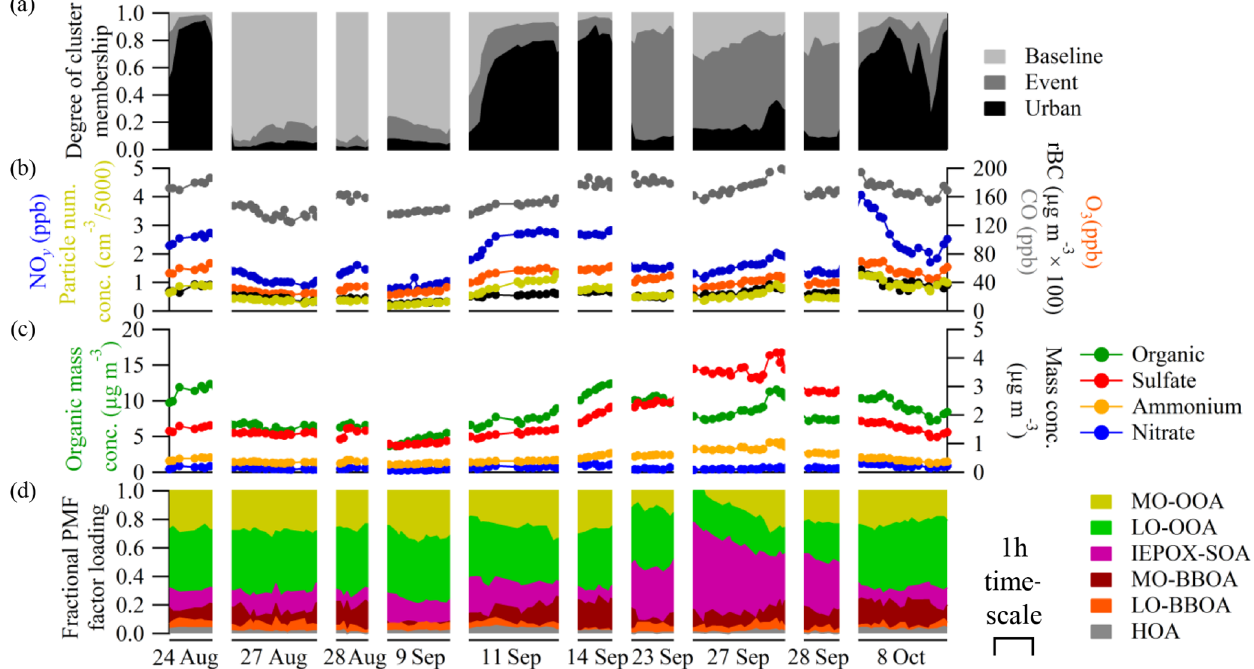
Figure 8. Results of the cluster analysis by FCM clustering for afternoon periods (12:00 to 16:00LT) presented by several case studies. The shown case studies represent 30% of the FCM results. (a) Degree of membership in each of the three clusters. The sum of degrees of membership across all clusters is unity. (b) Pollution indicators: concentrations of NO y , O 3 , CO, rBC, and particle number count are plotted. (c) PM 1 mass concentrations for organic, sulfate, nitrate, and ammonium species. (d) Fractional contribution of each factor to the PM 1 organic mass